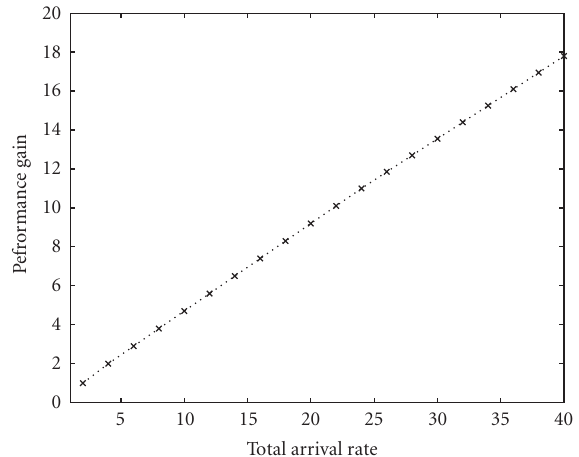
Figure 5: The performance gain, measured by the average number of clients sharing the same downloaded file, as a function of the total arrival rate per hour to a system which serves 100